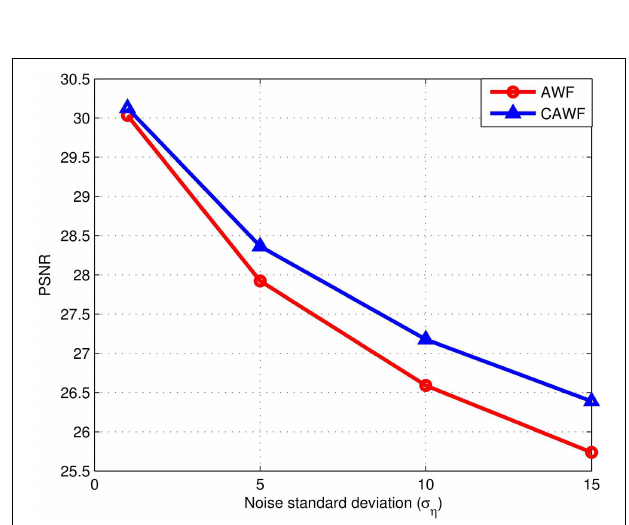
10 and the number of frames, P , varies from 1 to 9. =